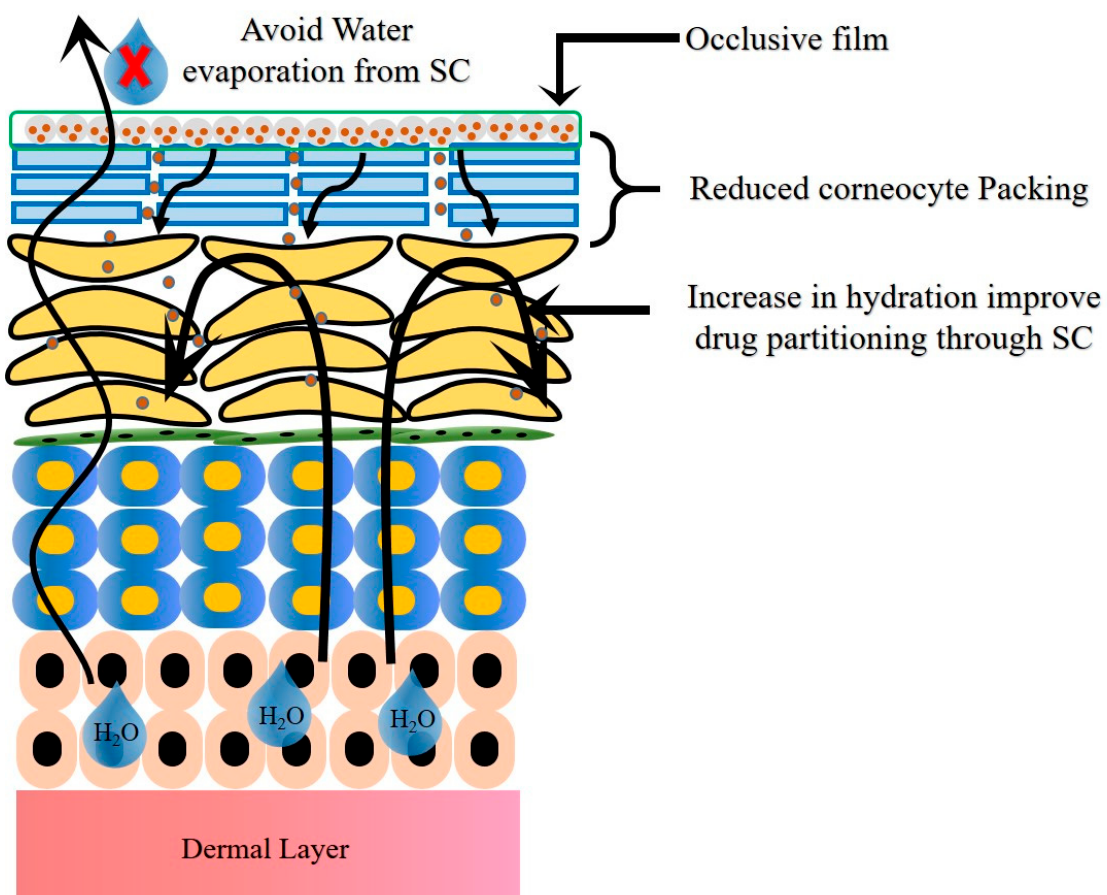
Figure 6. Mode of permeation from NLCs through psoriatic skin .